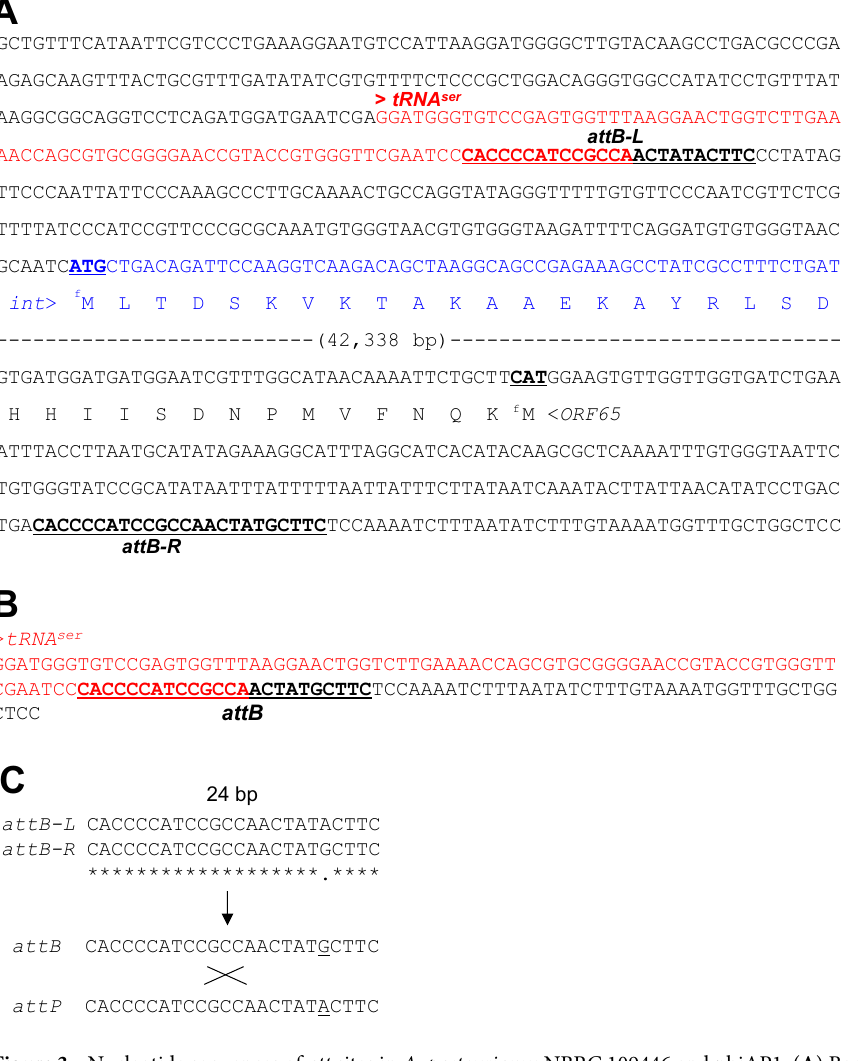
Figure 3. Nucleotide sequences of att sites in A. pasteurianus NBRC 109446 and phiAP1. ( A ) Bacterial host att sites ( attB-L and attB-R ) underlined are located in the genomic boundary region between the host and phiAP1. The tRNA ser gene is shown in red letters. ( B ) The attB site in the phiAP1-cured C-27 strain is underlined. The tRNA ser gene is shown in red letters. ( C ) Comparison of the nucleotide sequences of the att sites with a length of 24